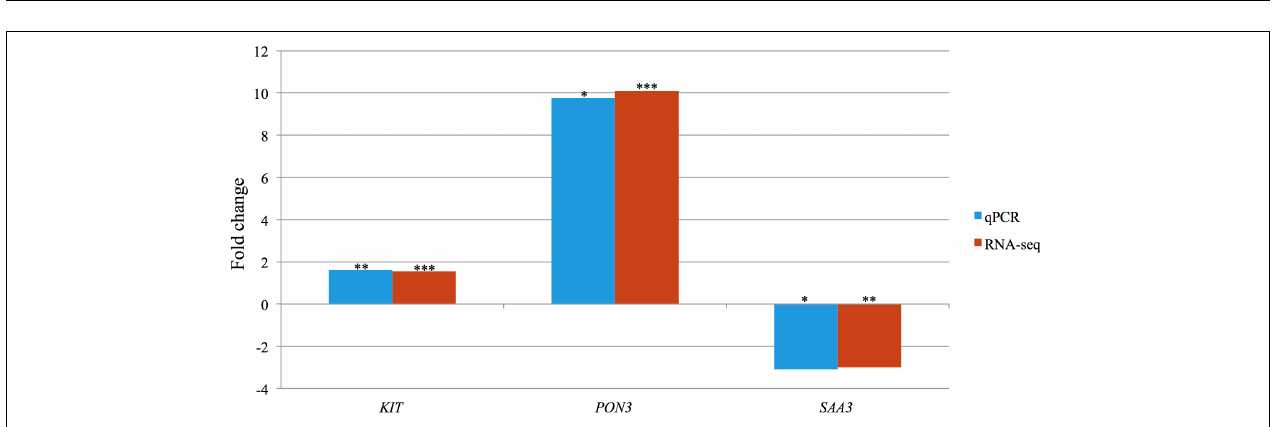
FIGURE 3 | Connection of genes affecting functions related to “carbohydrate metabolism,” “lipid metabolism,” and “small molecule biochemistry” represented in a gene network (network 12). Biological relationship between genes is depicted as an edge/line (solid lines and dashed lines show direct and indirect interactions, respectively). Colors represent up- (red) and down- (green) regulated genes in high-feed efficient pigs.